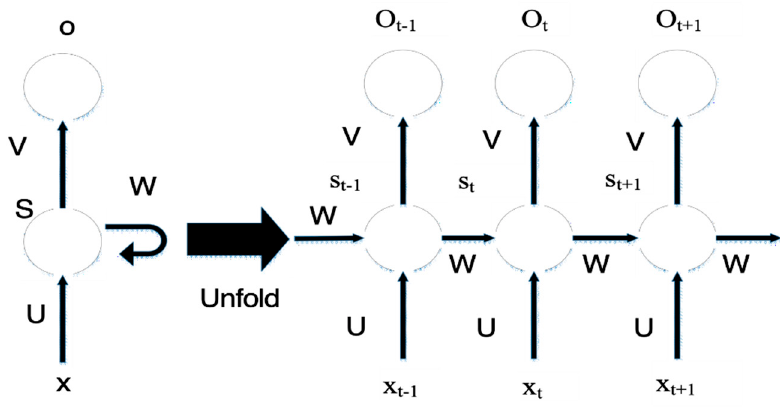
Figure 4. RNN (recurrent neural network) Network Architecture.